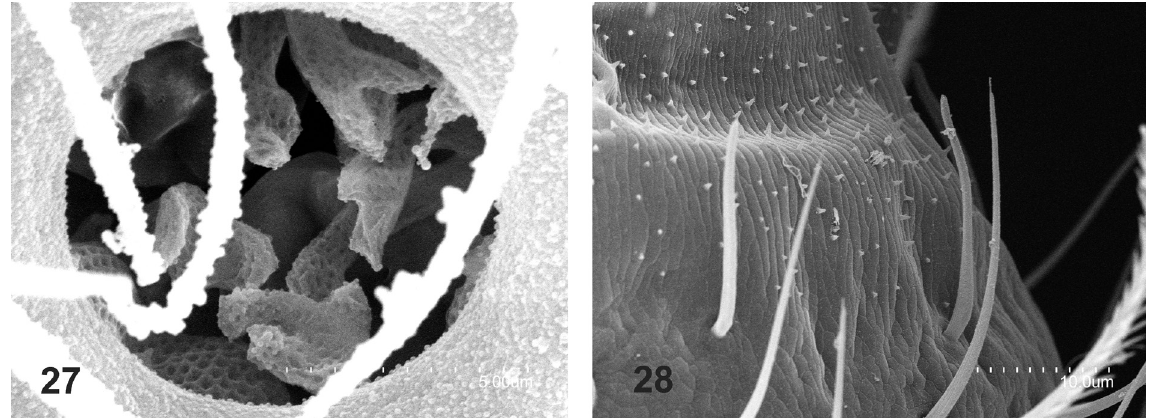
Figs 27−28. Turkmenocampa edaphica Sendra & Sánchez-García sp., ♂, paratype (Coll. AS). 27 . Cupuliform organ in the last antennomere. 28 . Medial antennomere with gouge